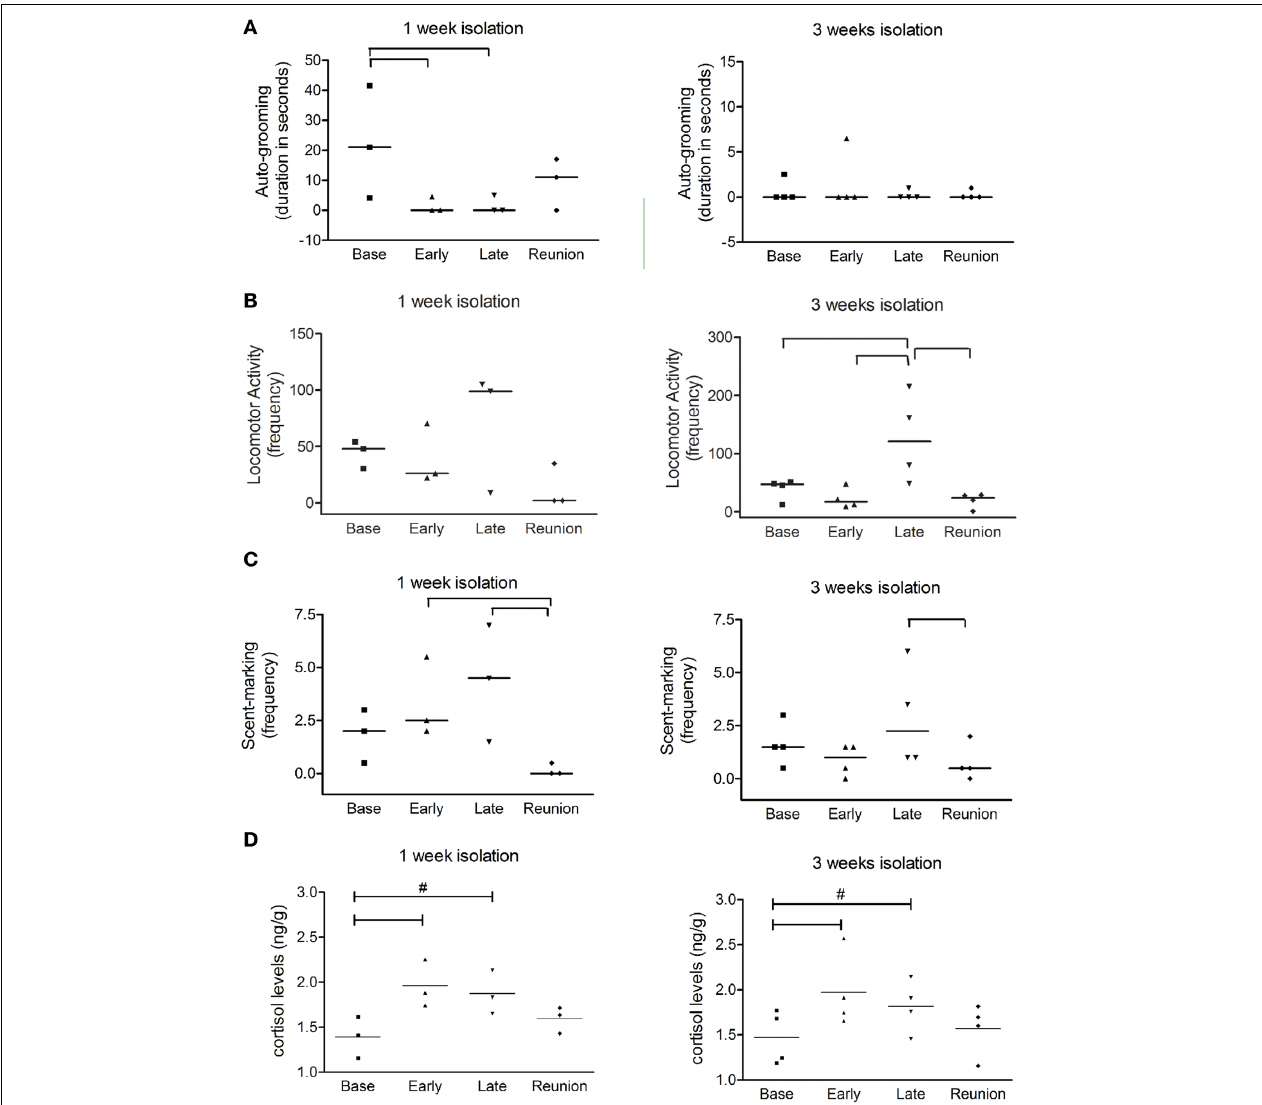
FIGURE 1 | Behavioral changes produced by isolation and cortisol measurement from fecal samples. Scatter plot graphs from behavioral observation data show (A) duration of auto-grooming (expressed in seconds); (B) frequencies of locomotor activity; and (C) frequencies of scent-marking duringbaselinephase(Base),twoinitialdaysofisolation(Early),twofinalsdays